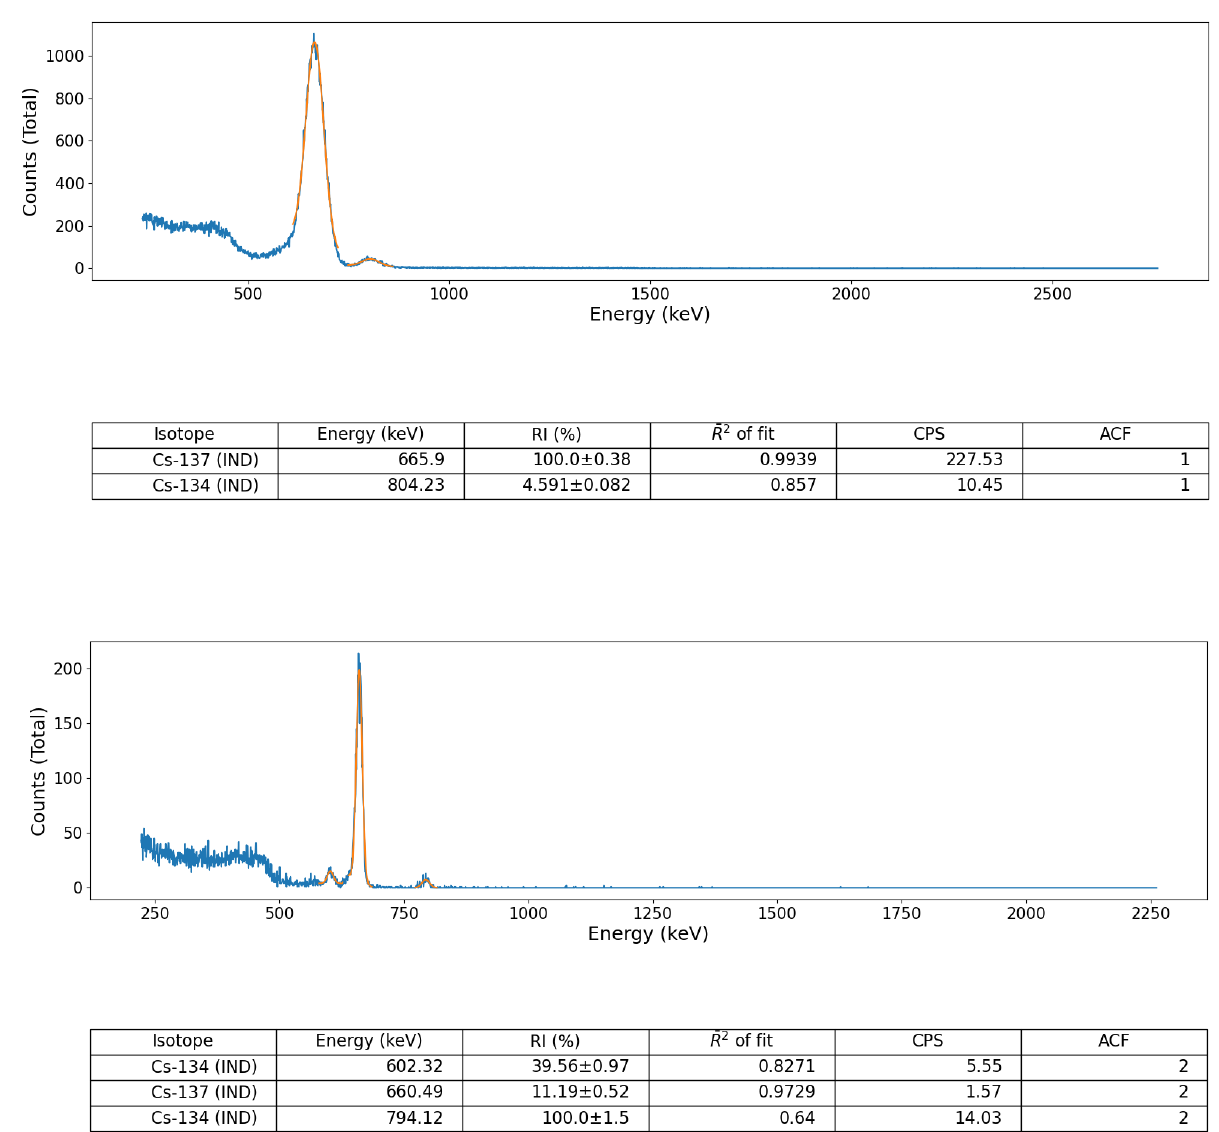
Figure 8. Peak-identified gamma-ray spectra, analysed after data collection (static spectrum), for a soil sample contaminated with Cs-137. Collected using a Hamamatsu C12137-01 CsI(Tl) scintillator type spectrometer module ( top ), and a Kromek GR1 CdZnTe (CZT) semiconductor type micro- gamma spectrometer ( bottom ). The table comprises the same nomenclature as detailed in Figure 5. The duration of data collection was 5 min